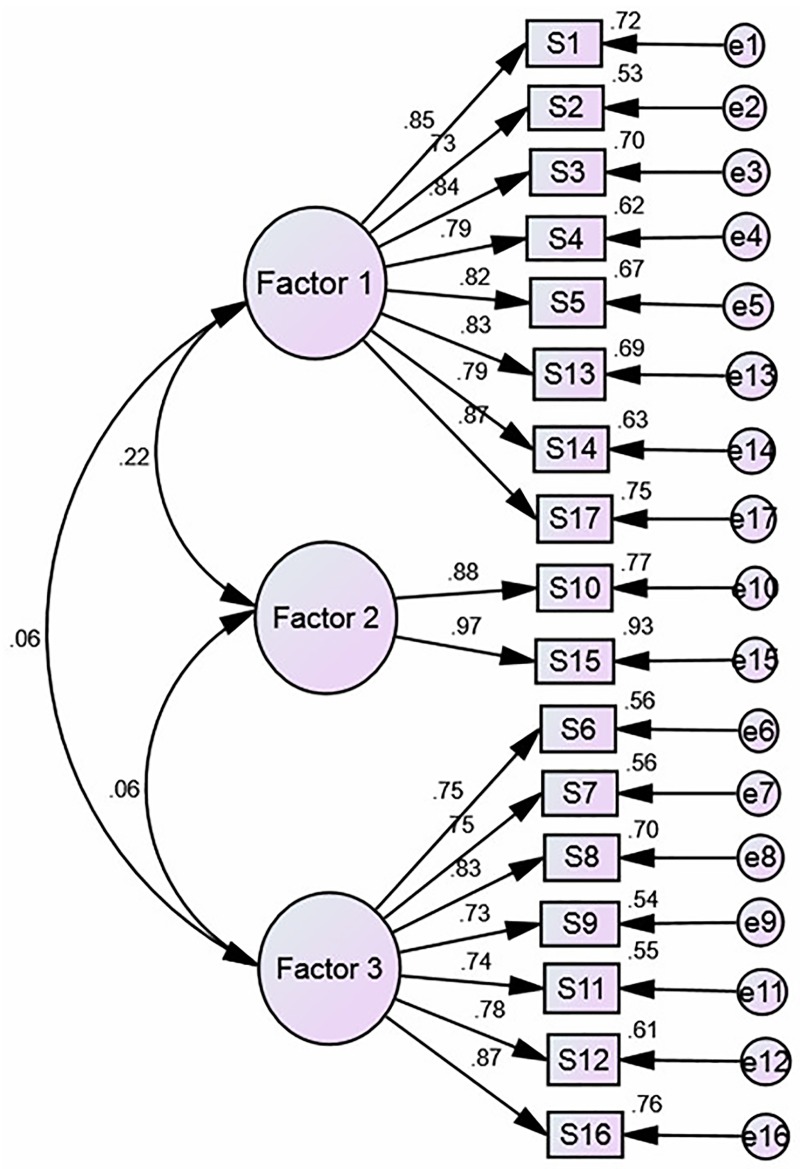
Standardized three-factor structural model of the SASE-CHI (n = 576).Note. SASE-CHI: the Chinese version of Self-care Ability Scale for the Elderly; Factor 1 (the repertoire, 8 items), Factor 2 (the environment, 2 items) and Factor 3 (the goals, 7 items); S1-S17: Item 1-Item 17, and each item is explained in Table 2. e1—e17: the measurement error of each observed variable to estimate latent variables.